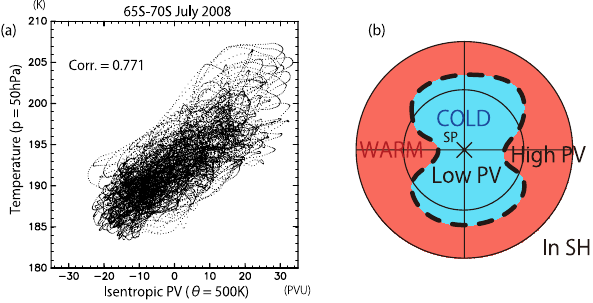
Fig. 5. (a) Scatter diagram of s = 1–3 potential vorticity fluctuation components on 500K isentropic surface and s = 0–3 temperature components at 50hPa in the latitude range of 65 ◦ S–70 ◦ S in July. “Corr.” stands for correlation efficient. (b) Schematic illustration of the relation between temperature and potential vorticity in the middle stratosphere of the Southern Hemisphere. Red (blue) area indicates warm (cold) temperature. The broken curve illustrates a polar night jet modulated by a planetary